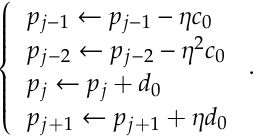
Figure 10. When 2 < j < 2 n − 1, the regenerative braking power is transferred by two adjacent converters.